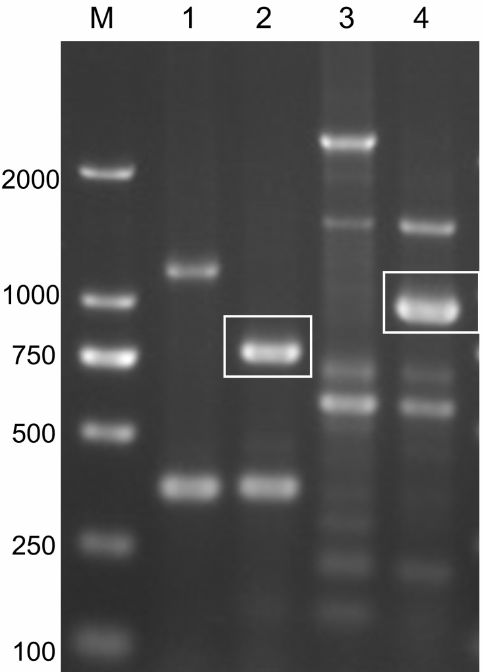
Figure 3. Electrophoresis image of PCR products in agarose gel. M: DL2000 bp marker; Line 1: the PCR product amplified from wild-type zebrafish genome by using GFP -F/R primers; Line 2: the PCR product amplified from EYE lines genome by using GFP -F/R primers; Line 3: the PCR product amplified from wild-type zebrafish genome by using Krt4-F and GFP -R primers; 4: the PCR product amplified from EYE lines genome by using Krt4-F and GFP -R primers. White boxes indicate the target bands (720 bp in Line 2, 916 bp in Line 4).